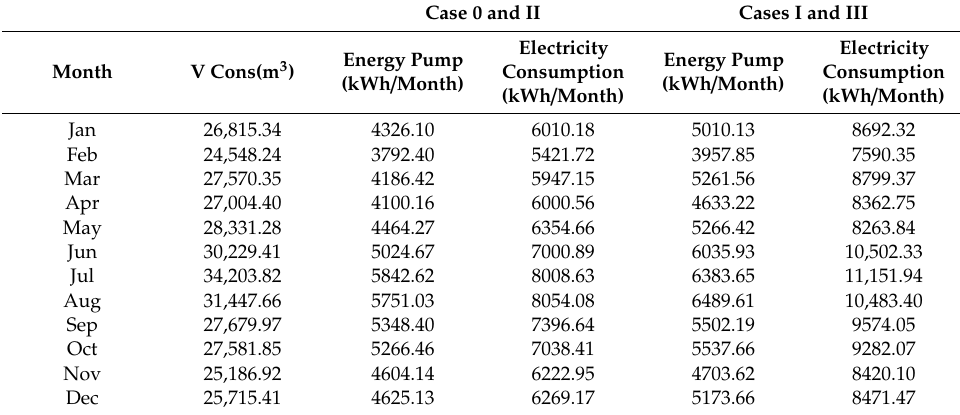
Table 3. Volume, electricity consumption, and monthly costs in the town (Case